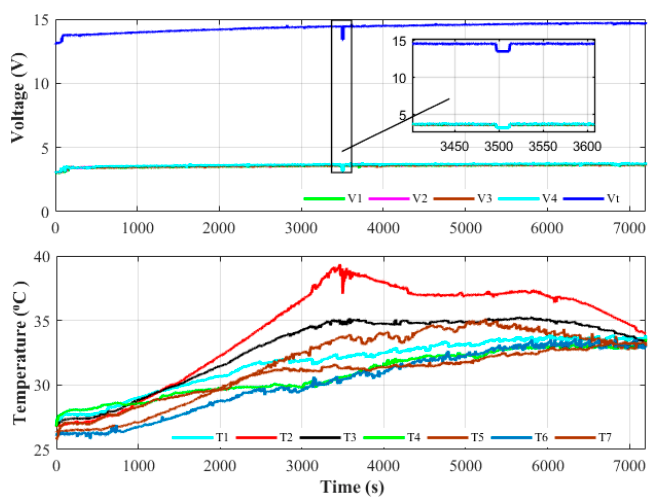
Figure 8. Voltage and temperature profile of the Li-ion battery (LIB).